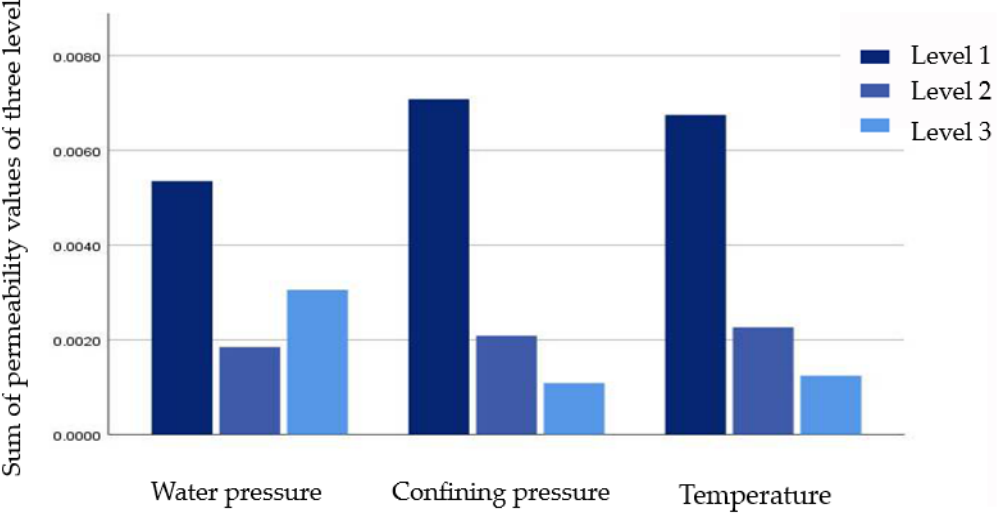
Figure 14. Trend analysis of orthogonal test results for subcategory II 2 sandstone.